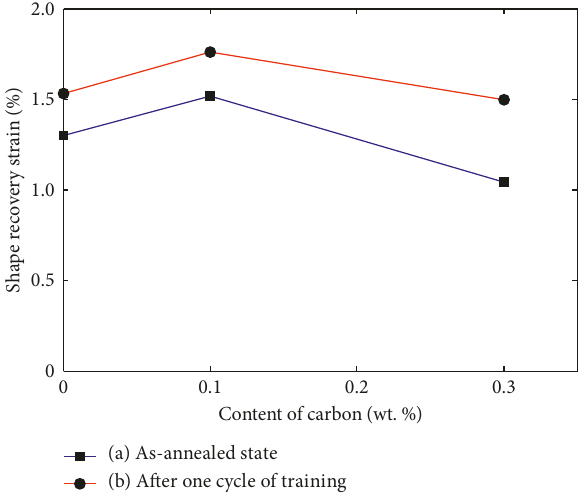
Figure 11: Dependence of shape recovery strain on C content of the alloys. (A) As-annealed state. (B) After one cycle of training.